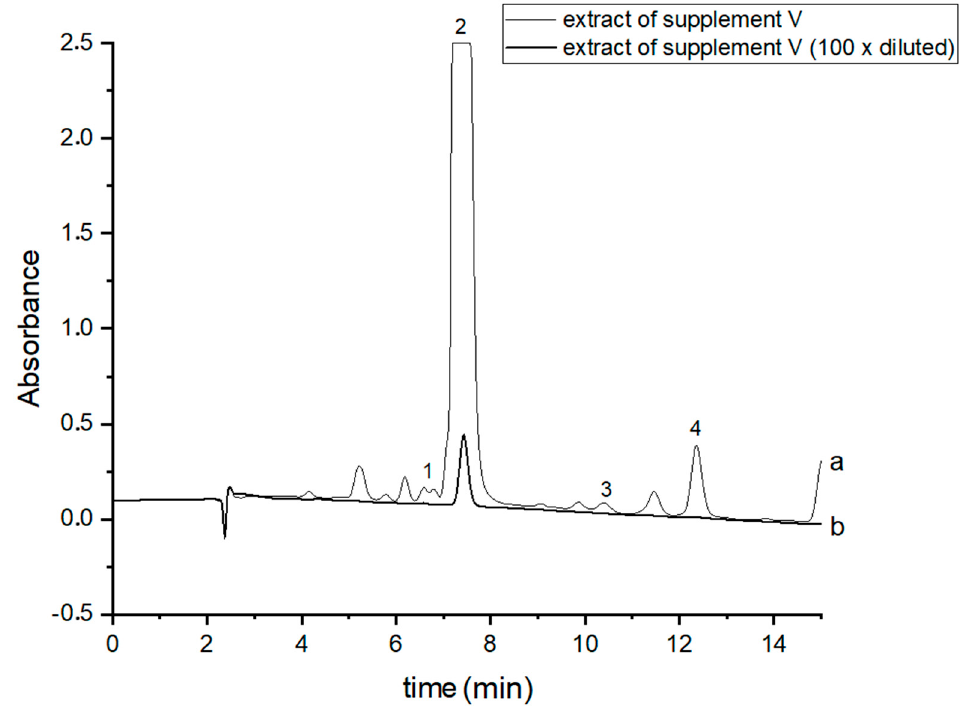
Figure 3. Chromatograms of the analyzed oil supplement V ‐ (a) original extract and (b) 100 times diluted extract. The compounds were detected at λ = 220 nm. 1—CBDA, 2—CBD, 3—CBN and 4— Δ 9 ‐ THC.